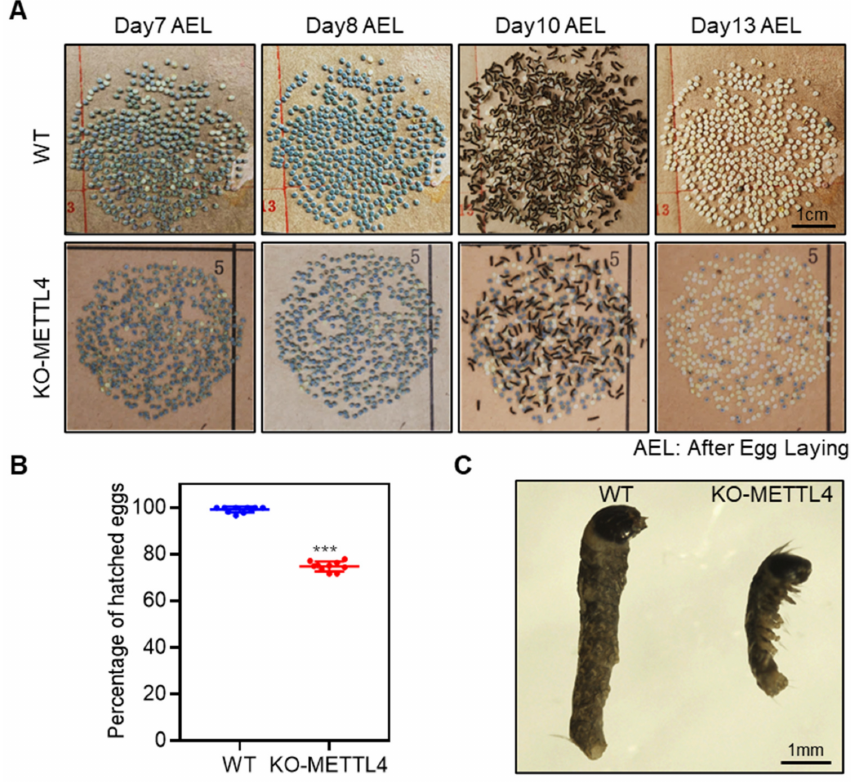
Figure 2. Depletion of BmMETTL4 caused developmental defect of silkworm embryo. ( A ) Time-lapse of embryonic development in KO-METTL4 and WT silkworms. Scale bar is 1 cm. ( B ) Percentage of hatched eggs that were laid from KO-METTL4 and WT silkworms. *** p < 0.001. ( C ) Representative images of the internal embryos of WT and KO-METTL4 dissected from eggs before hatching. Scale bar is 1